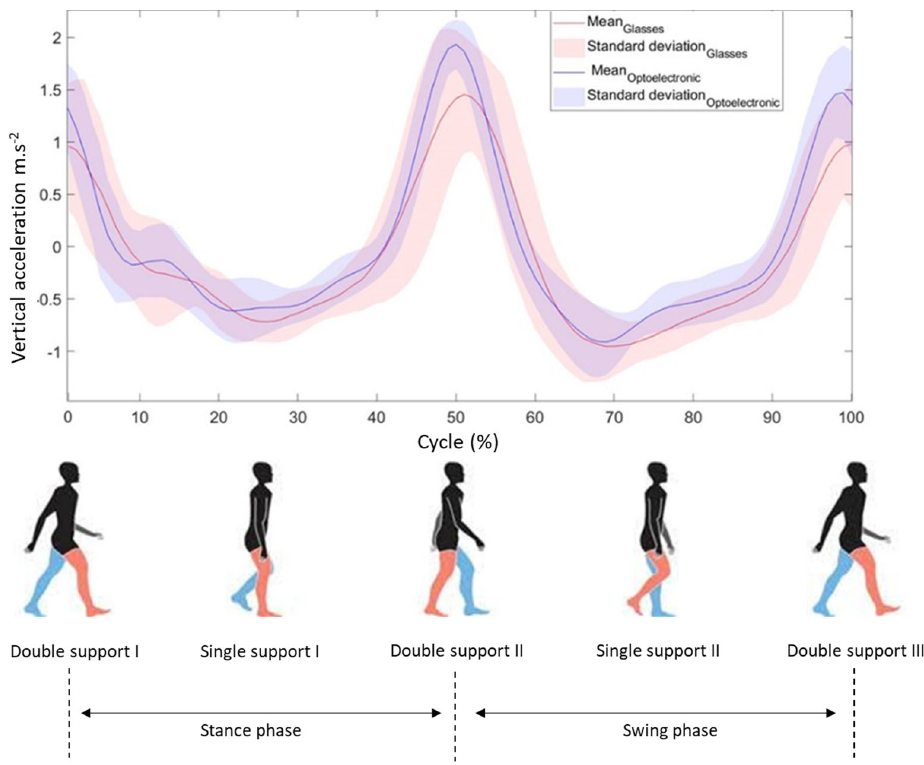
Figure 3. Acceleration signals from the glasses and optoelectronic system during gait cycle in 0.90 m/s speed without a cervical collar for one participant (red and blue colors indicate the right and the left lower limb, respectively).